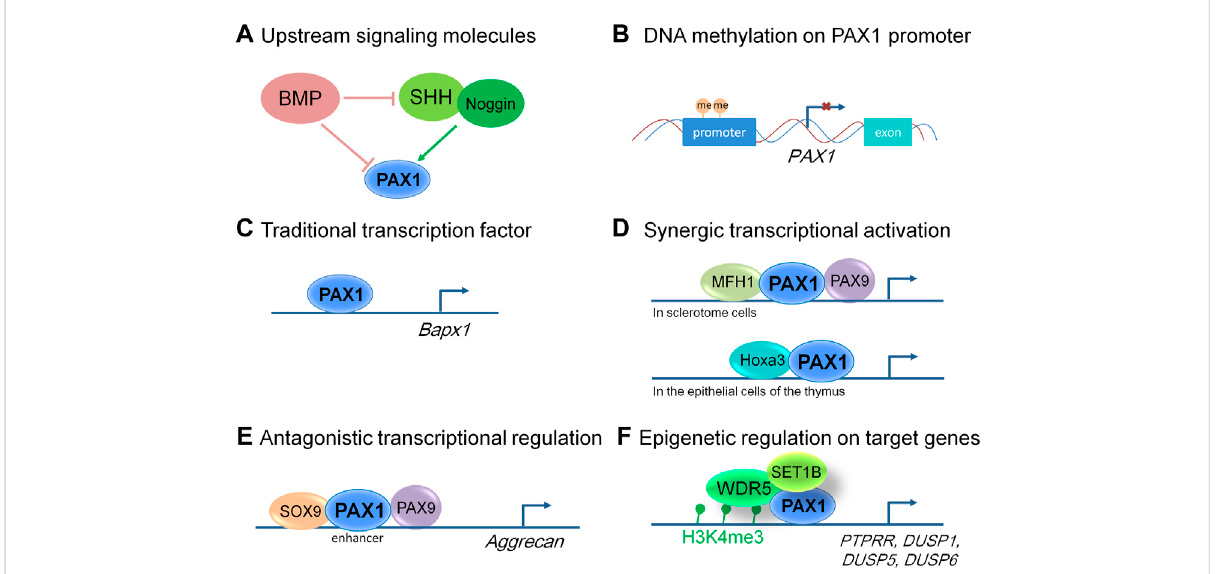
Molecular modes of action of PAX1 and its up and downstream events. (A) Signaling molecules function upstream of PAX1 in embryonic development. (B) PAX1 is hypermethylated at its promoter region in many kinds of cancer cells, leading to decreased level of PAX1 expression. (C) PAX1 can function as a traditional transcription factor to transactivate regulatory sequences in the Bapx1 promoter region in sclerotome cells. (D) PAX1 acts on cell proliferation synergistically with MFH1 and PAX9 in sclerotome cells and Hoxa3 in the epithelial cells of the thymus. (E) PAX1 and PAX9 play antagonistic roles with SOX9 in the enhancer region of Aggrecan in the developing vertebral column. (F) PAX1 forms a complex with WDR5 and SET1B to regulate the H3K4me3 level within the promoters of PTPRR , DUSP1 , DUSP5 , and DUSP6